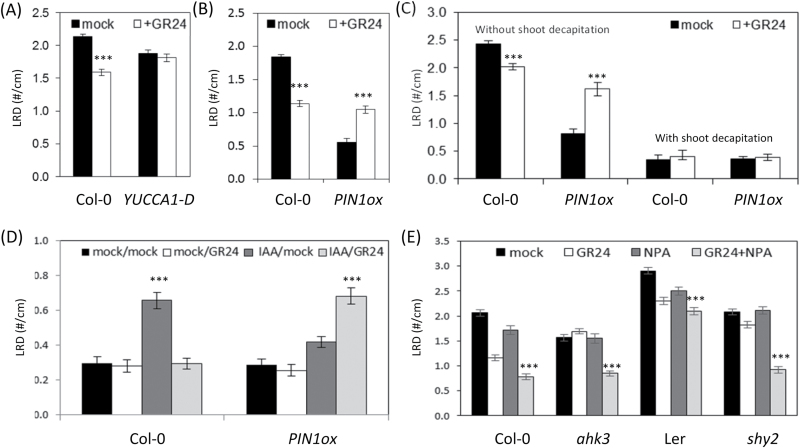
Dependence of GR24 action on the plant auxin status. (A) LRD of WT and YUCCA-overexpressing (YUCCA1-D) plants, grown with and without GR24. (B) LRD of WT and PIN1-overexpressing (PIN1ox) plants, grown with and without GR24. (C) LRD of Col-0 and 35S:PIN1 (PIN1ox) plants with and without shoot decapitation, grown in the presence or absence of GR24. (D) LRD of Col-0 and PIN1ox plants with decapitation and with and without apically applied IAA grown in the presence or absence of GR24. Mock/mock: decapitated plants grown in the absence of GR24 and without applied IAA; mock/+GR24: decapitated plants grown in the presence of GR24 and without applied IAA; IAA/mock: decapitated plants grown in the absence of GR24 and with apically applied IAA; IAA/+GR24: decapitated plants grown in the presence of GR24 and with apically applied IAA. (E) LRD of Col-0, ahk3, Ler and shy2-24 mutants upon treatment with mock, GR24, NPA, or NPA+GR24. Data presented are means ± SE of three biological repeats (n>20). ***P<0.001, according to ANOVA mixed-model statistical analyses.